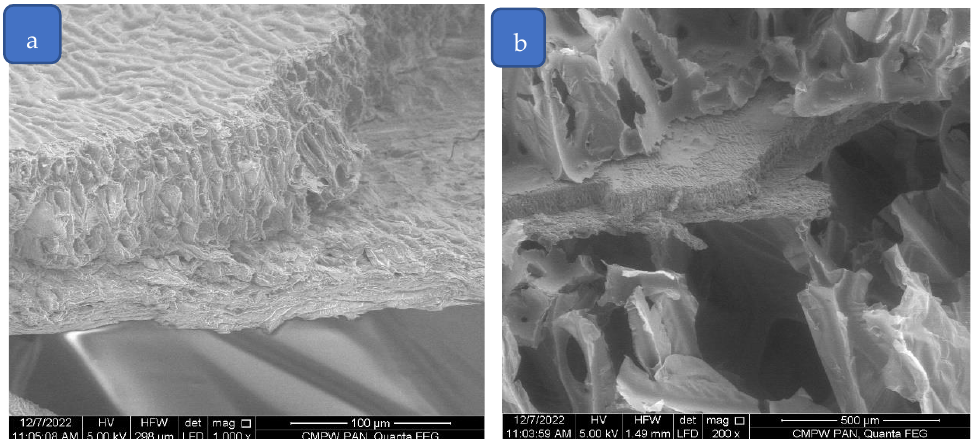
Figure 3. SEM images of buckwheat hull structure ( a ) and buckwheat hulls building into the structure of rigid PU foam ( b ).